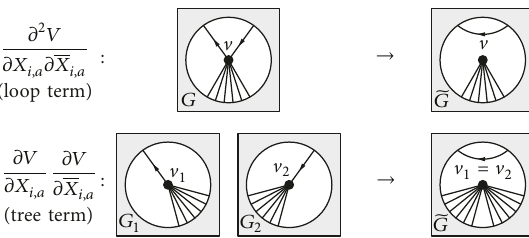
Figure 4: Action of the differential operators on the vertices of the effective